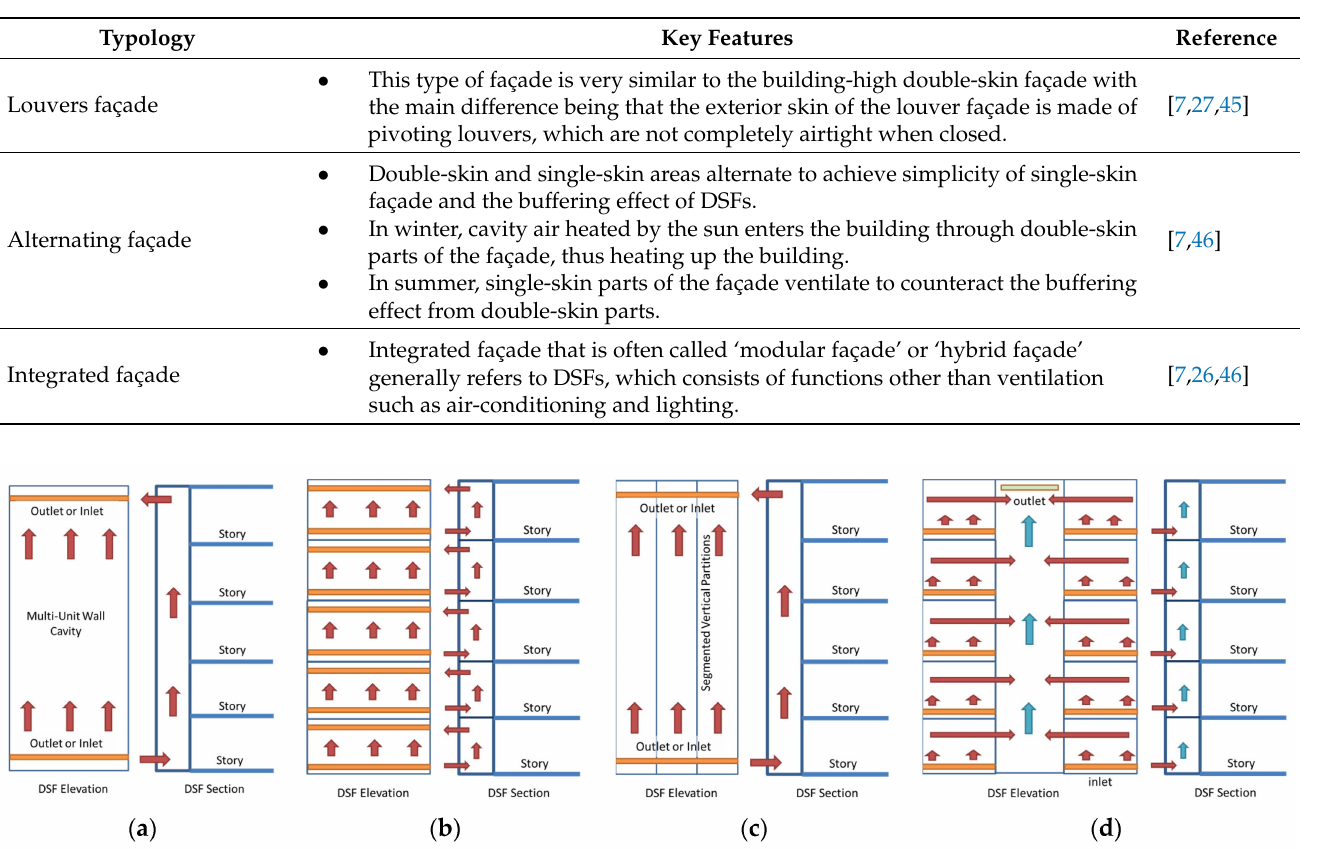
Figure 1. Representative DSF Cavity Configurations: ( a ) Building High Configuration; ( b ) Story High Configuration; ( c ) Box Configuration; ( d ) Shaft